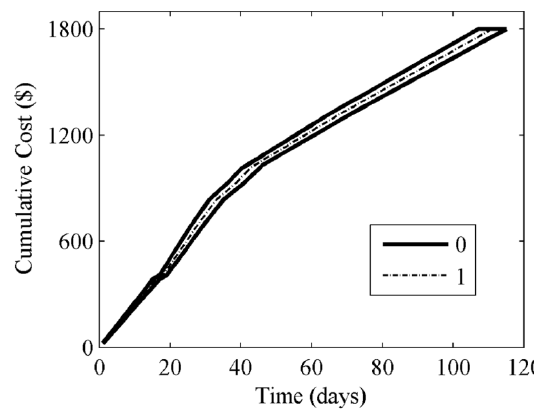
Fig. 12. Fuzzy cash flow without task